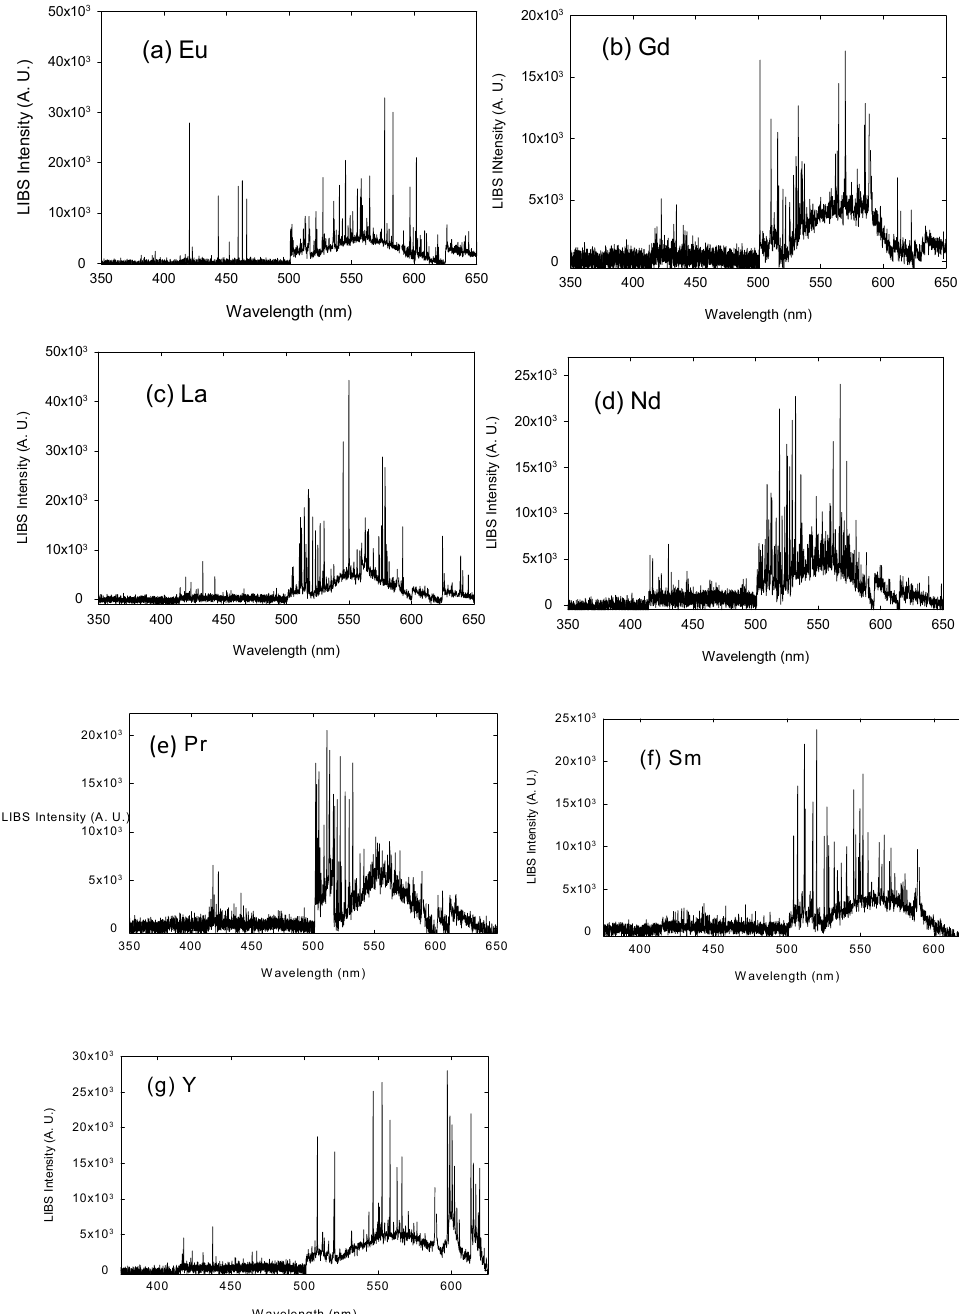
Figure 3. The broadband LIBS spectra for 5% of ( a ) europium, ( b ) gadolinium, ( c ) lanthanum, and ( d ) neodymium, ( e ) praseodymium, ( f ) samarium, and ( g ) yttrium in 95% graphite powder. The distinguishing features for all the elements that were studied are shown in Table 1.